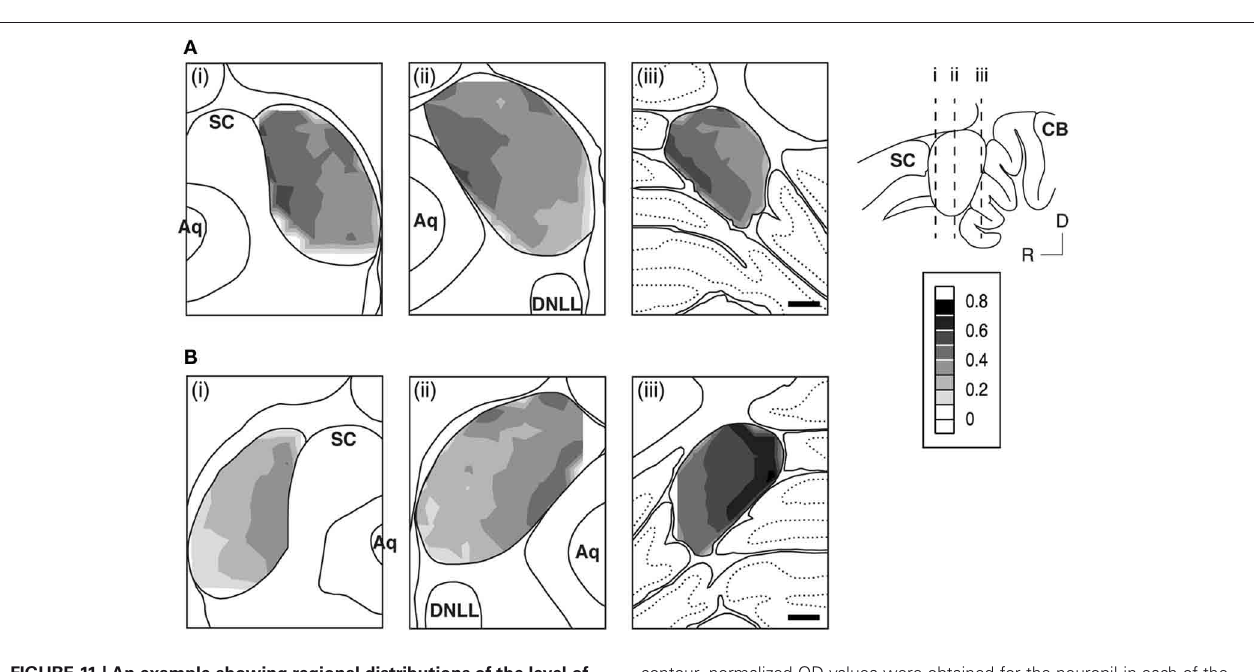
FIGURE 11 | An example showing regional distributions of the level of neuropil immunoreactivity to antibodies against the GABA B R1 (A) and the GABA B R2 (B) subunits over the IC in sections from different rostrocaudaul locations of the IC indicated in the inset. For making a